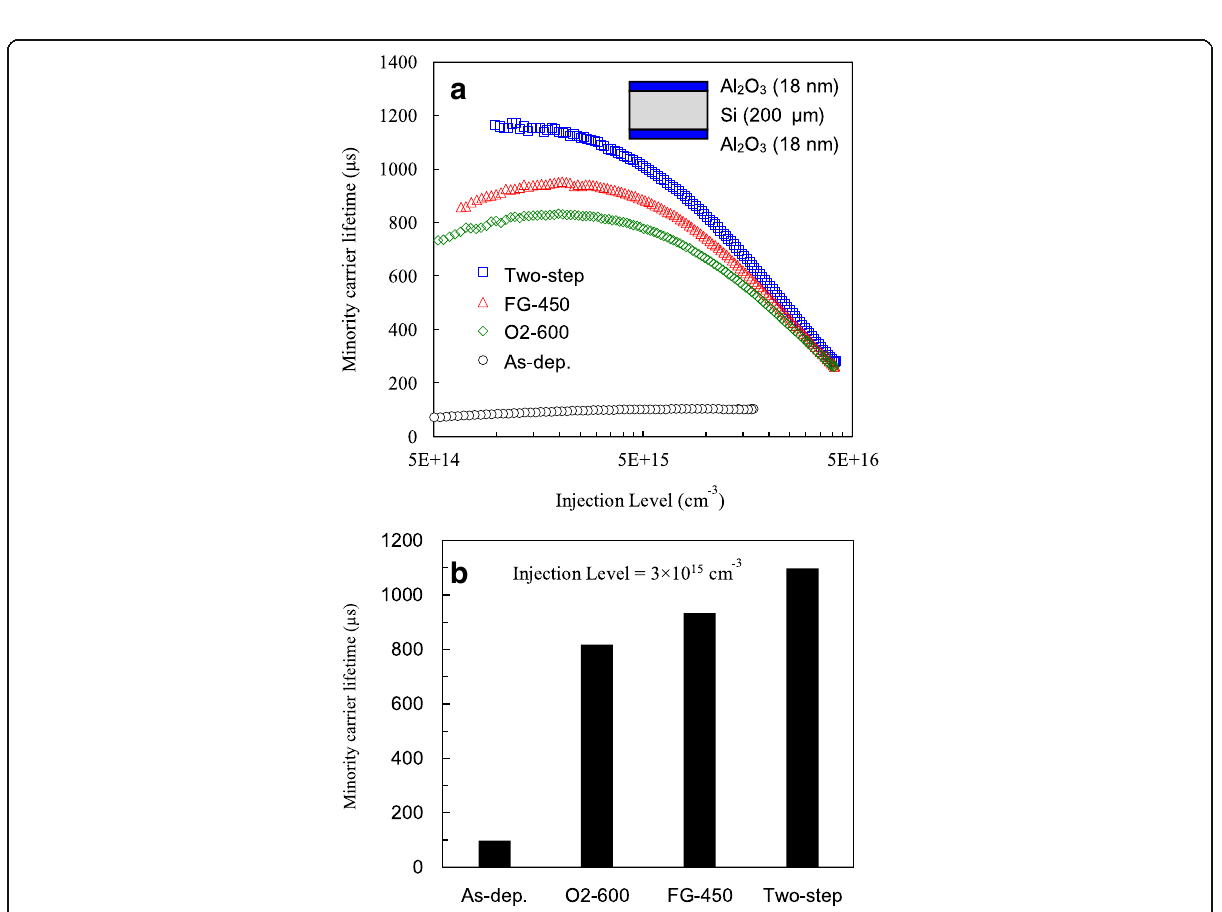
Fig. 2 a Injection-level-dependent minority carrier lifetime. b Lifetime at an injection level of 3 × 10 15 cm − 3 for Al 2 O 3 /Si/Al 2 O 3 samples with O 2 , FG, and two-step